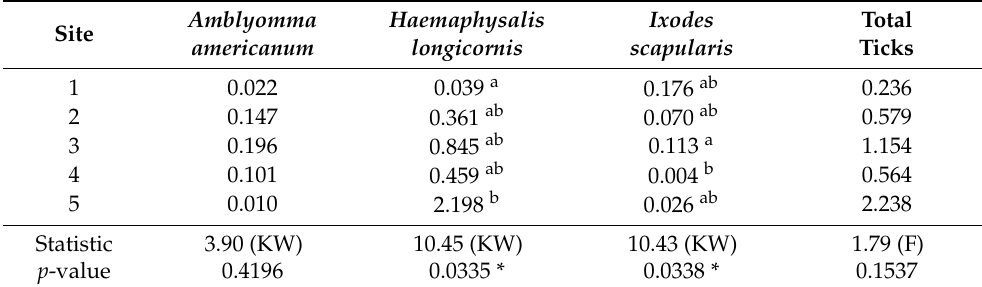
Table 2. Tick abundance in five different ecotone sites in New Brunswick, NJ. Kruskal–Wallis (KW) tests and ANOVA (F) were used to analyze significant differences between sites in total ticks and per tick species: p < 0.05 (*). Different letters represent significant differences using Dunn’s multiple comparisons tests ( p <